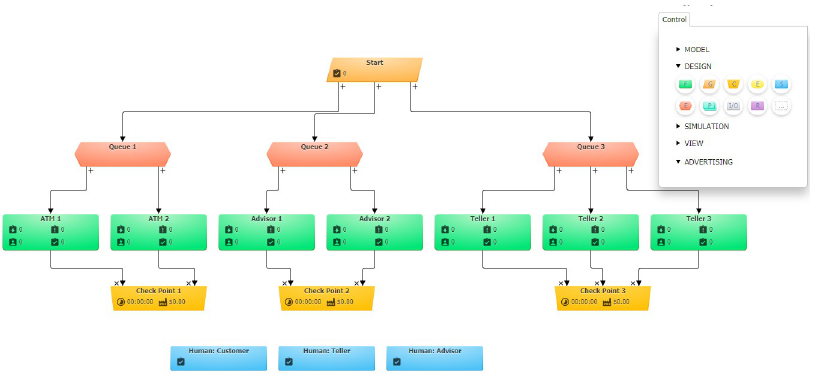
Fig 6. BPSimulator model showing bank